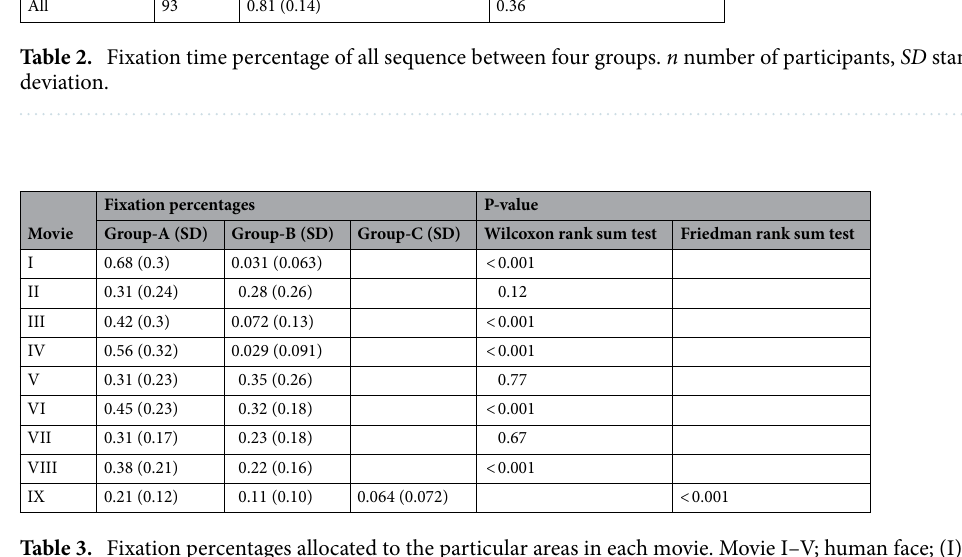
Table 3. Fixation percentages allocated to the particular areas in each movie. Movie I–V; human face; (I) eye blinking; (II) mouth moving; (III) still image; (IV) silent; (V) talking; Movie VI; biological motion; Movie VII; human and geometric patterns (same size) VIII; human and geometric patterns (small window), Movie IX; joint attention. SD standard